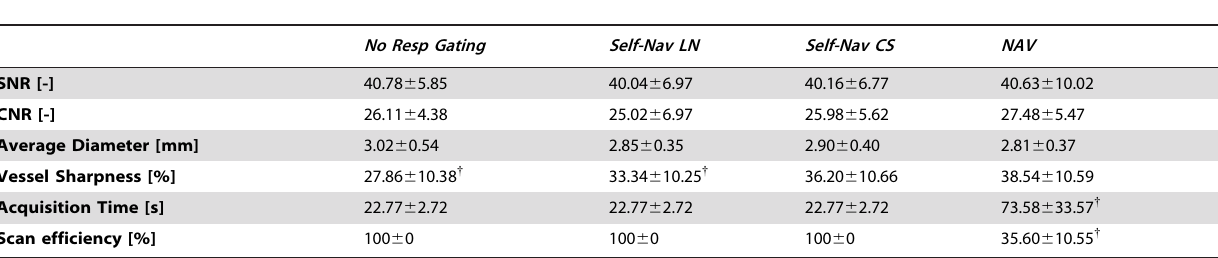
Table 1. In vivo results: quantitative